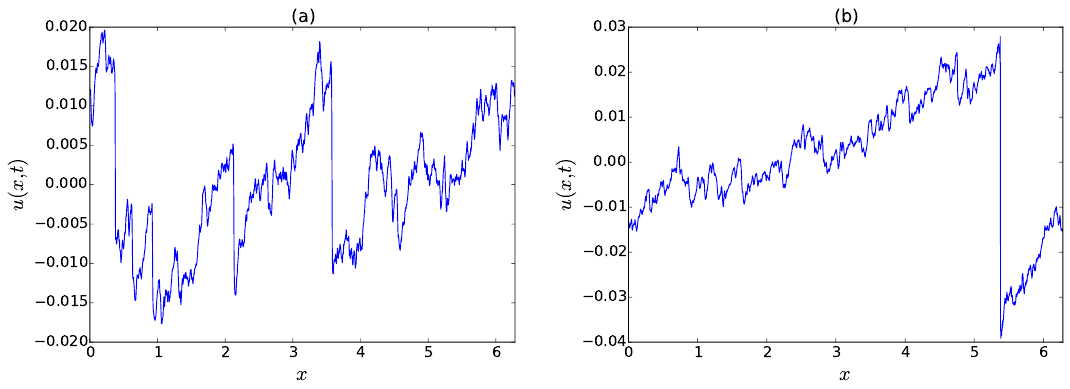
Figure 3. ( a ) typical realization of the velocity field u ( x , t ) in DNS of Burgers turbulence ( α = 1 in Equation (26)). The velocity field exhibits a sawtooth profile that is due to the formation of large negative velocity gradients; ( b ) velocity field realization that belongs to the largest velocity gradient attained in the DNS belonging to Table